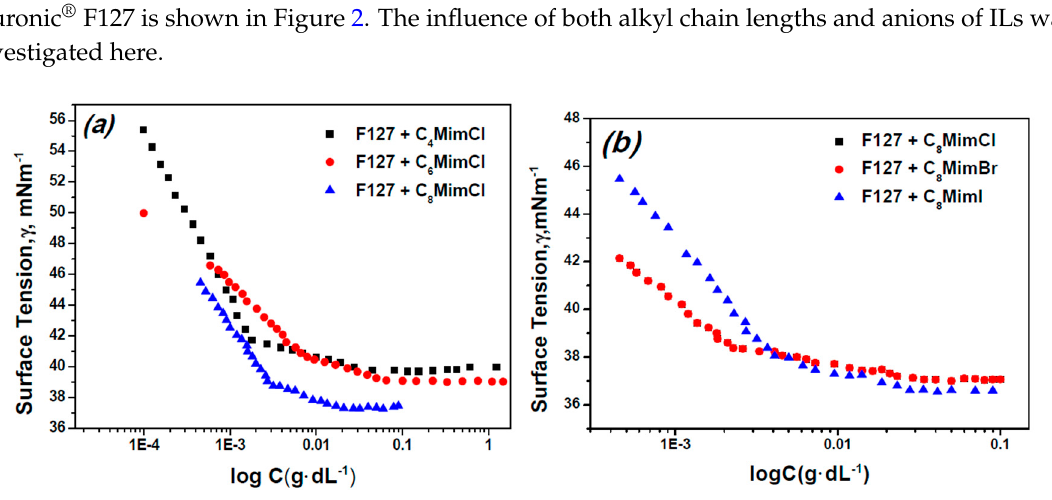
Table 1. Parameters obtained from DLS measurements.